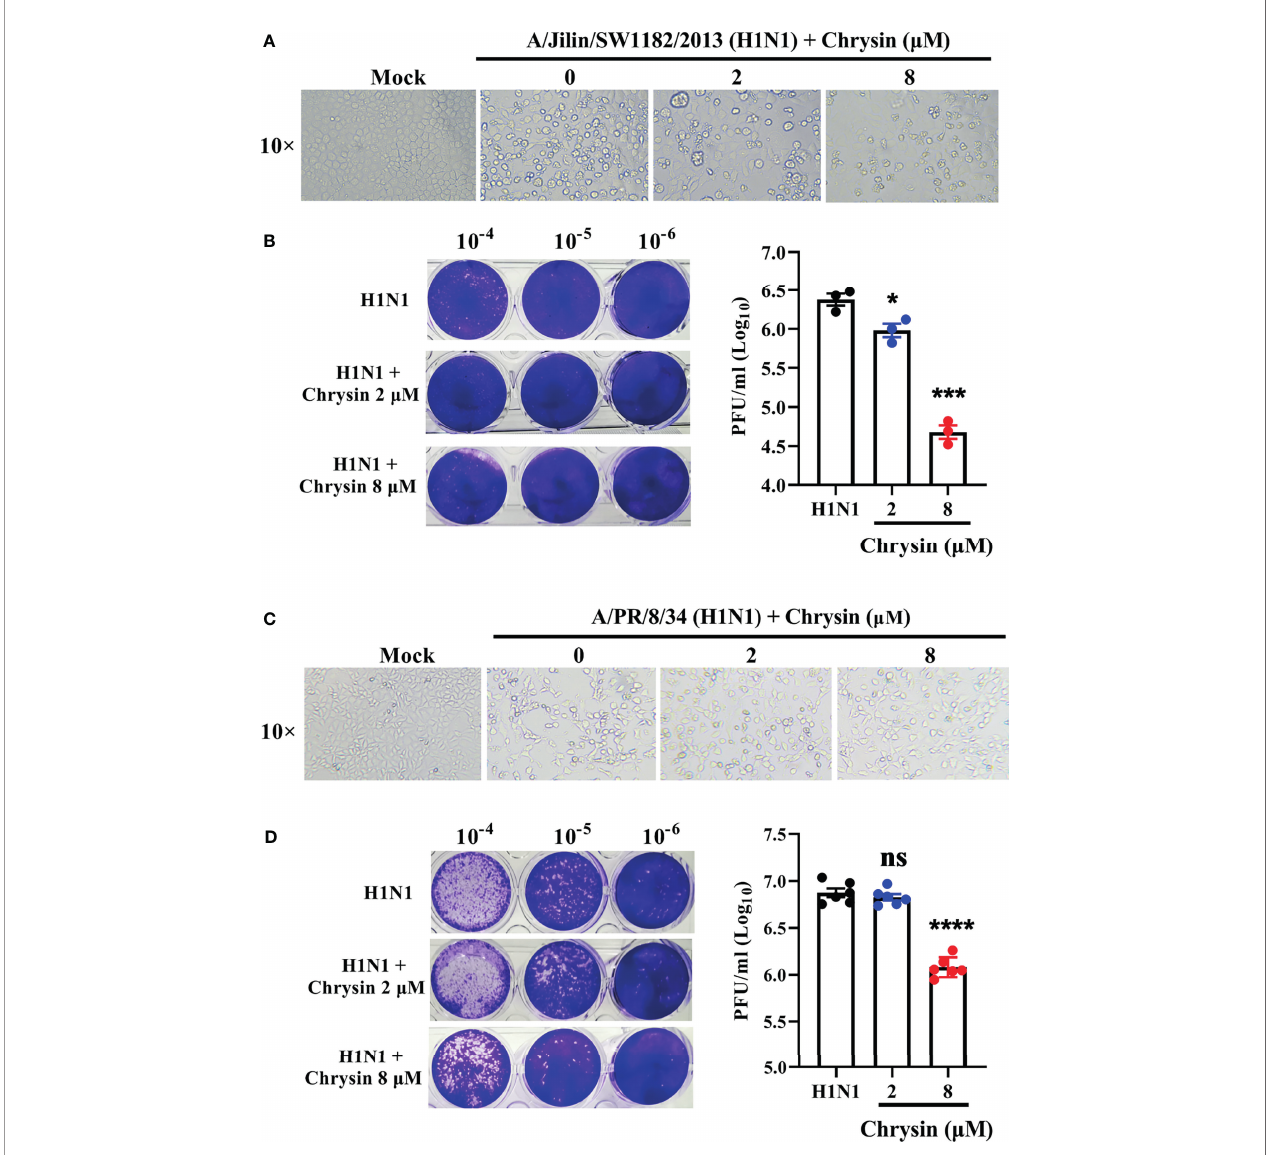
FIGURE 2 | In vitro inhibitory activity of chrysin against H1N1 in fl uenza virus infection. (A, C) Microscopy observations of virus-induced CPE reduction in MDCK cells by chrysin. A/Jilin/SW1182/2013 (H1N1) virus (MOI = 0.5) (A) or A/PR/8/34 (H1N1) (MOI = 0.5) (C) were incubated with chrysin (0, 2, or 8 m M) at 4°C for 30 min before infecting MDCK cells at 37°C for 2 hours. Subsequently, the viral inoculum was removed and replaced by adding chrysin (0, 2, or 8 m M). CPE was observed at 24 hours post-incubation by microscopy (original magni fi cation × 10). (B, D) A/Jilin/SW1182/2013 (H1N1) virus (MOI = 0.5) (B) or A/PR/8/34 (H1N1) (MOI = 0.5) (D) was mixed with a different concentration of chrysin (0, 2, or 8 m M) at 4°C for 30 min, then infected with MDCK cells. Two hours after infection, the viral inoculum was removed, and the cells were treated with chrysin for 24 hours. The viral titer was detected by plaque assay and shown as a log value. Representative images of viral plaques in each histogram are shown (left panel). Data are expressed as the mean ± SEM of triplicate samples. *P < 0.05, ***P < 0.001, ****P < 0.0001 by one- way ANOVA with Dunnett ’ s multiple comparisons test when compared to the H1N1 control group. ns, no signi fi cant